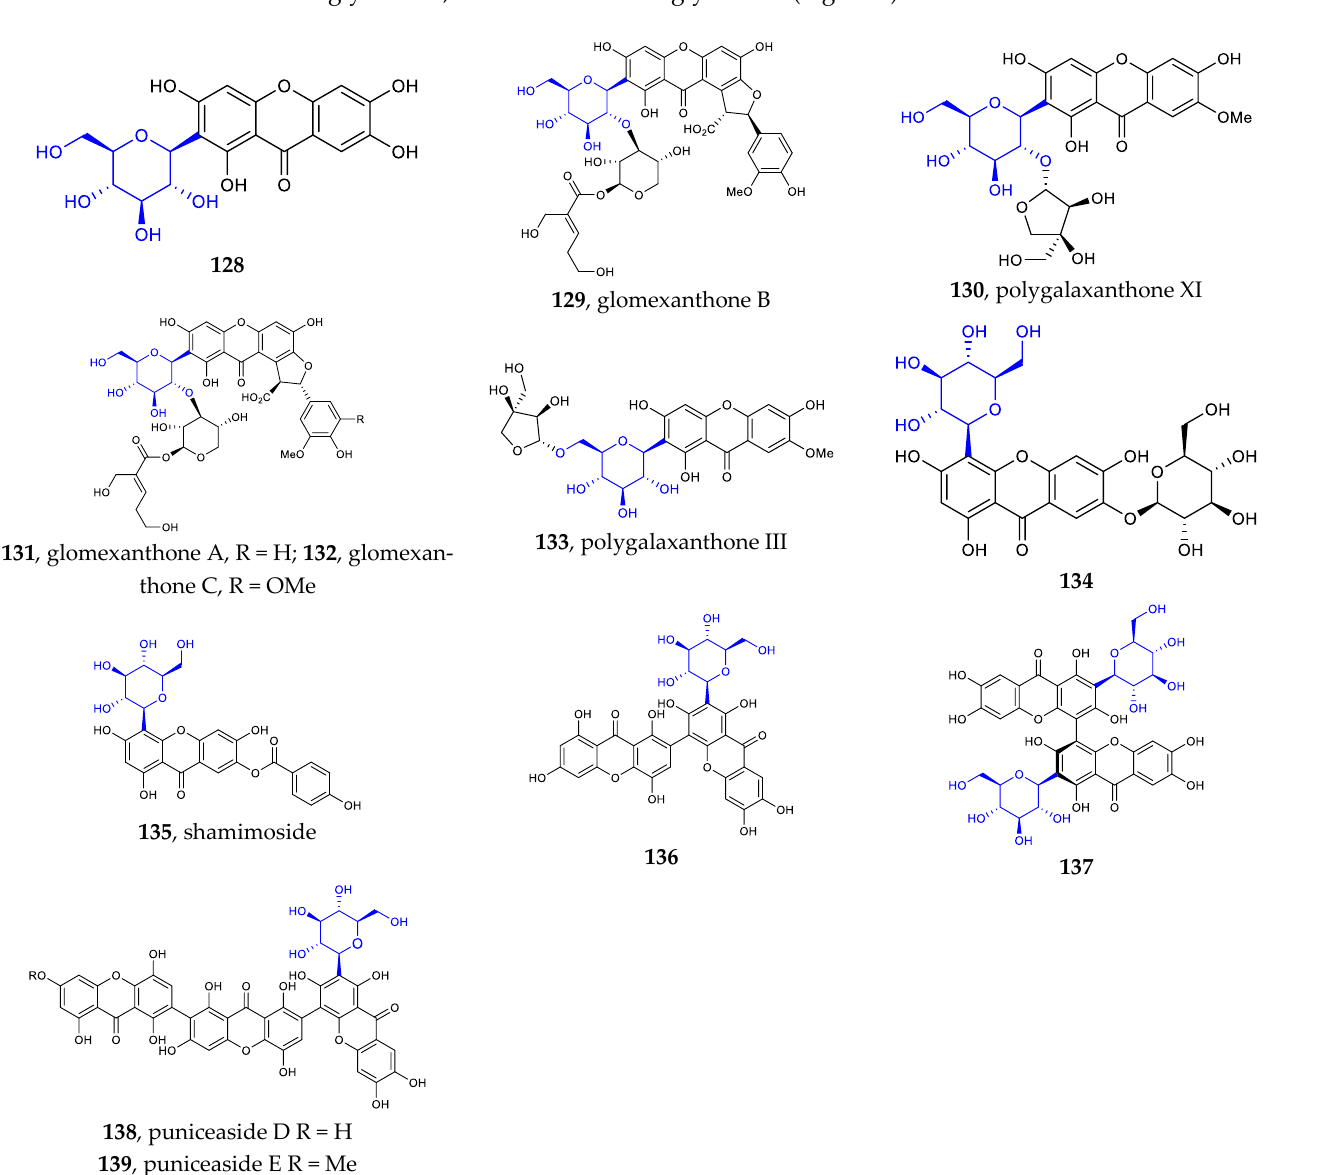
Figure 4. Chemical structures ( 128 – 139 ) of xanthone C -glycosides.